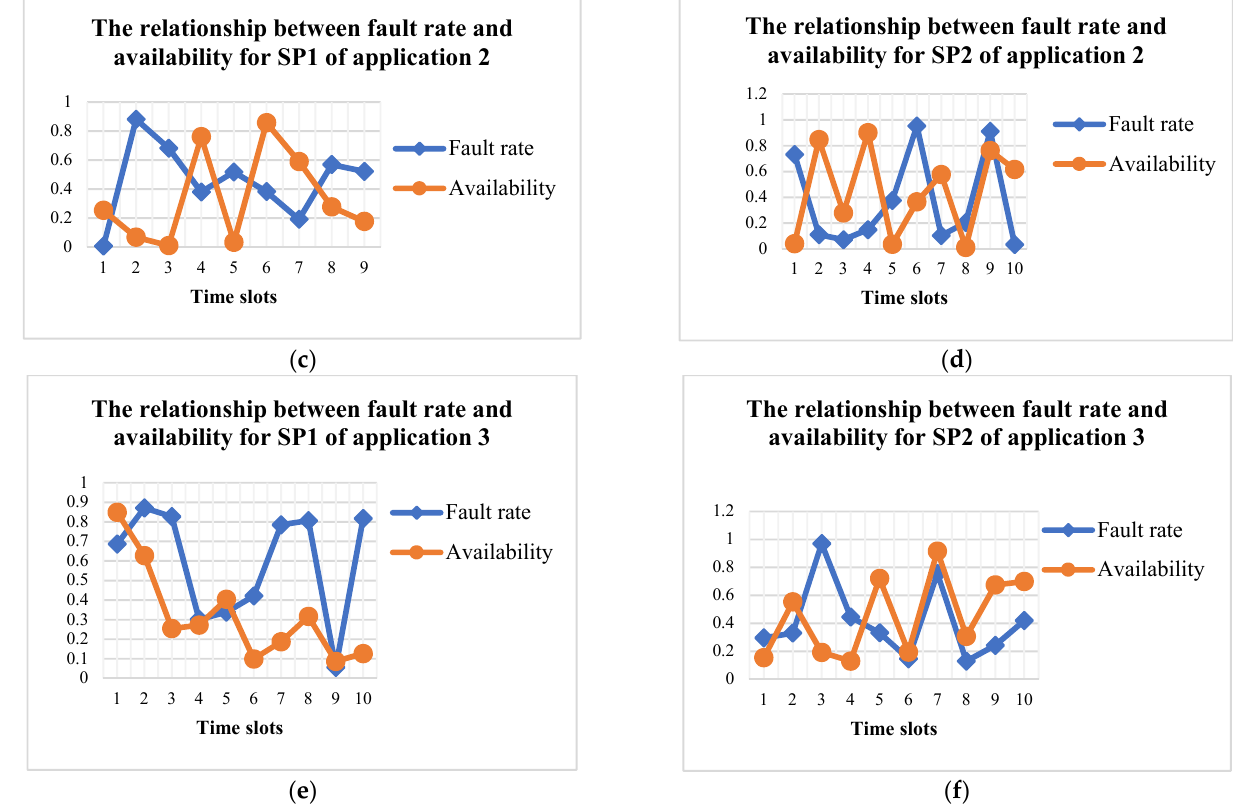
Figure 10. The relationship between fault rate and availability: ( a ) The relationship between them for SP1 of application 1; ( b ) The relationship between them for SP2 of application 1; ( c ) The relationship between them for SP1 of application 2; ( d ) The relationship between them for SP2 of application 2; ( e ) The relationship between them for SP1 of application 3; ( f ) The relationship between them for SP2 of application 3.